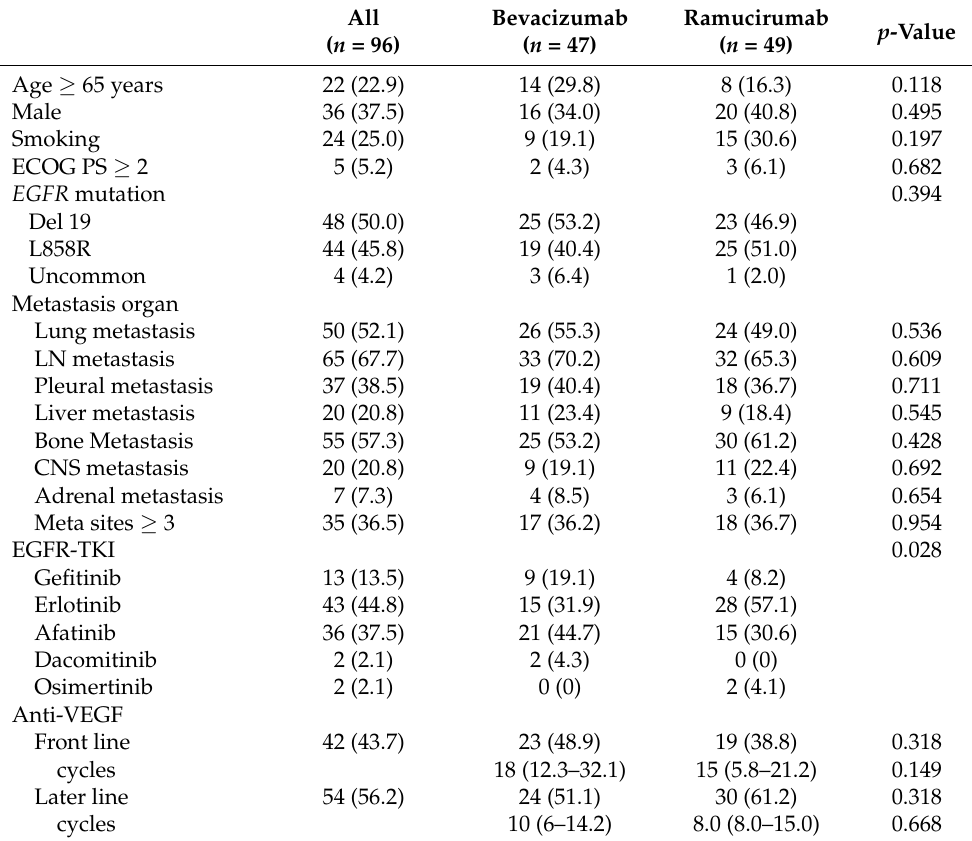
Table 1. Characteristics of EGFR-mutated metastatic non-small-cell lung cancer patients receiving bevacizumab or ramucirumab in combination with epidermal growth factor receptor-tyrosine kinase inhibitor